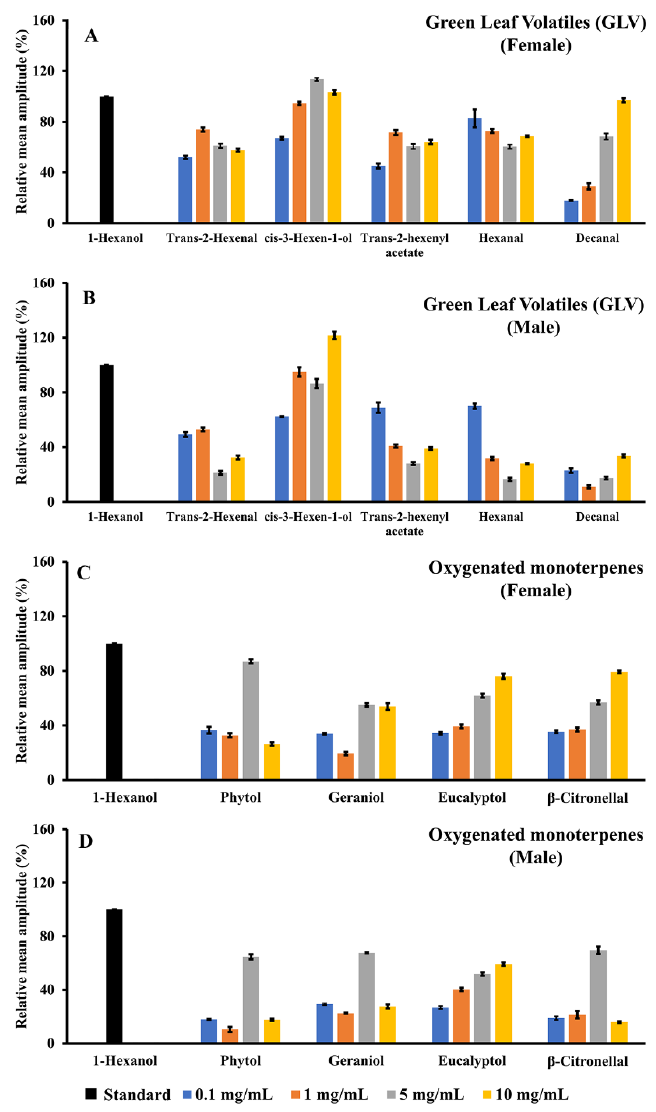
Figure 4. Mean normalized electroantennography (EAG) responses for GLV ( A , B ) and oxygenated monoterpenes ( C , D ) compounds in female and male Aulacophora foveicollis to plant volatiles at 0.1, 1, 5.0 and 10 mg/mL concentration.